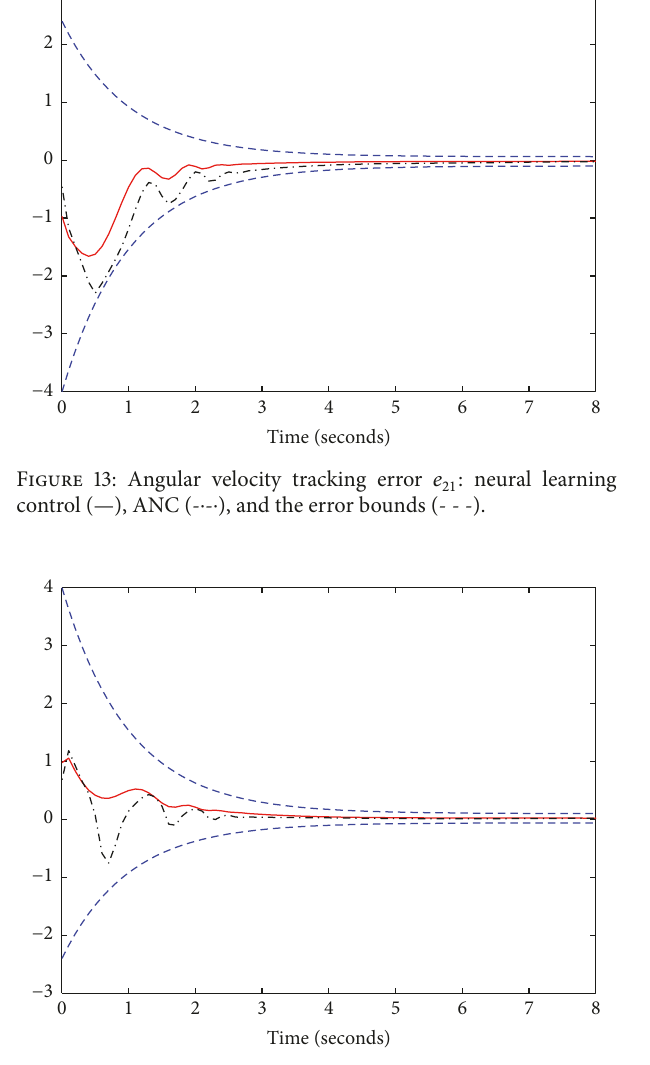
Figure 14: Angular velocity tracking error 𝑒 22 : neural learning control (—), ANC (- ⋅ - ⋅ ), and the error bounds (- - -).